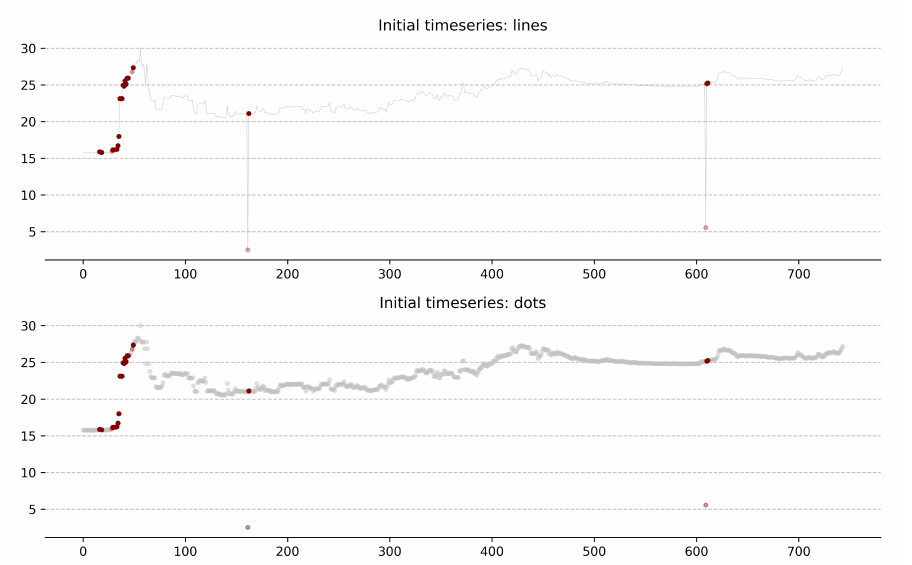
Figure 9. Non-seasonal time-series with outliers. Anomalies were found with an anomaly likelihood threshold of